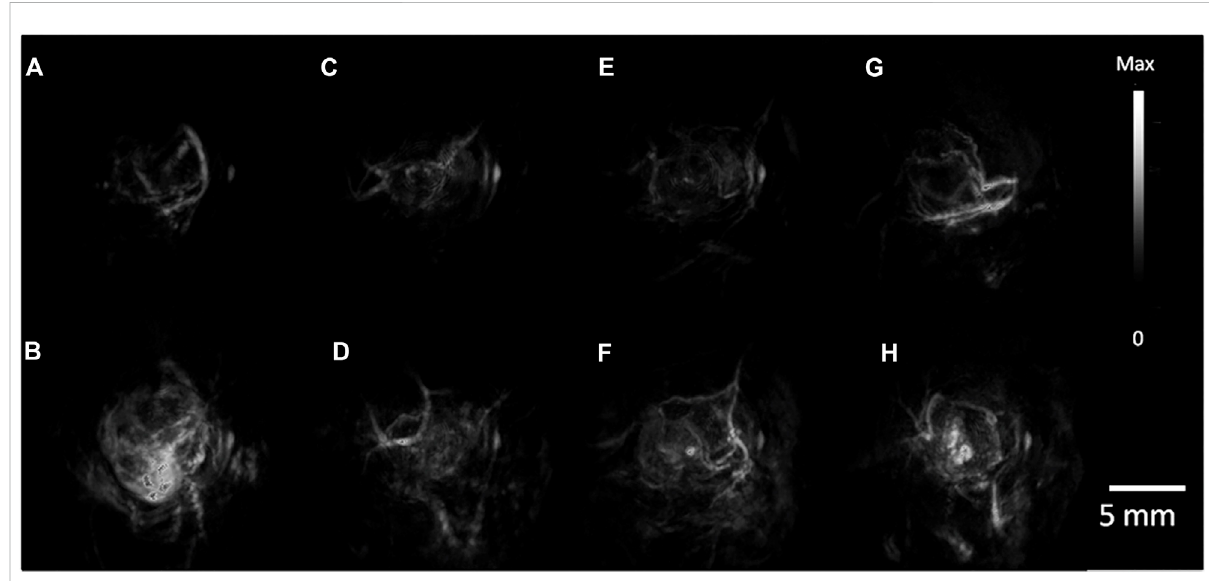
FIGURE 6 PA Tumor Imaging with passively targeted gold nanorods (GNRs). (A) MDA-435S tumors serve as a positive control. Panels (B – D) , are 2008, HEY, SKOV3 tumors respectively with global thresholding values before tail-vein injection of 200 ul of 5.4 nM GNR (756 nm resonance) contrast. (E – H) are6 hpostinjection.PAimageswereconstructedwithavolumetricrendering via Amidesoftware[reproducedfrom(Jokerstetal.,2012)with permission from American Chemical Society].